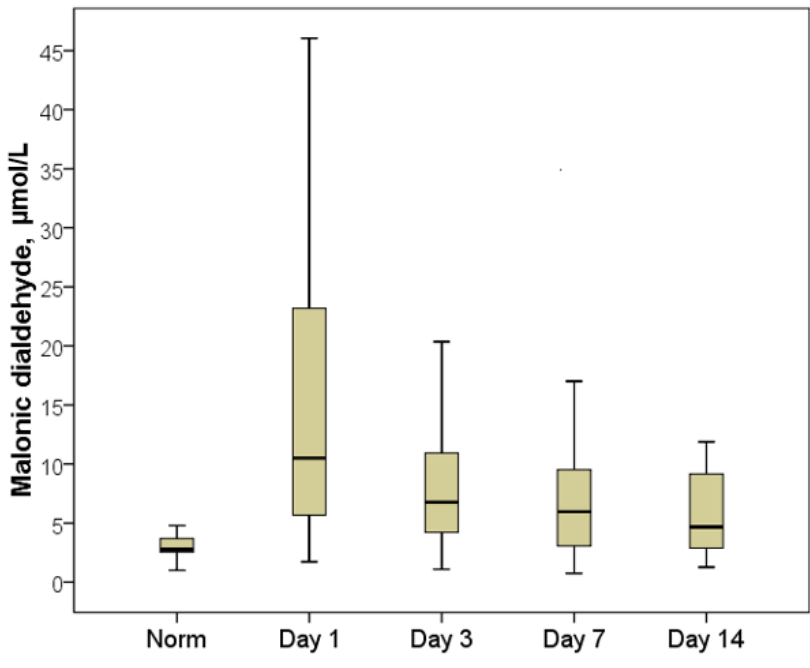
Figure 6. Dynamics of the malondialdehyde indicator.